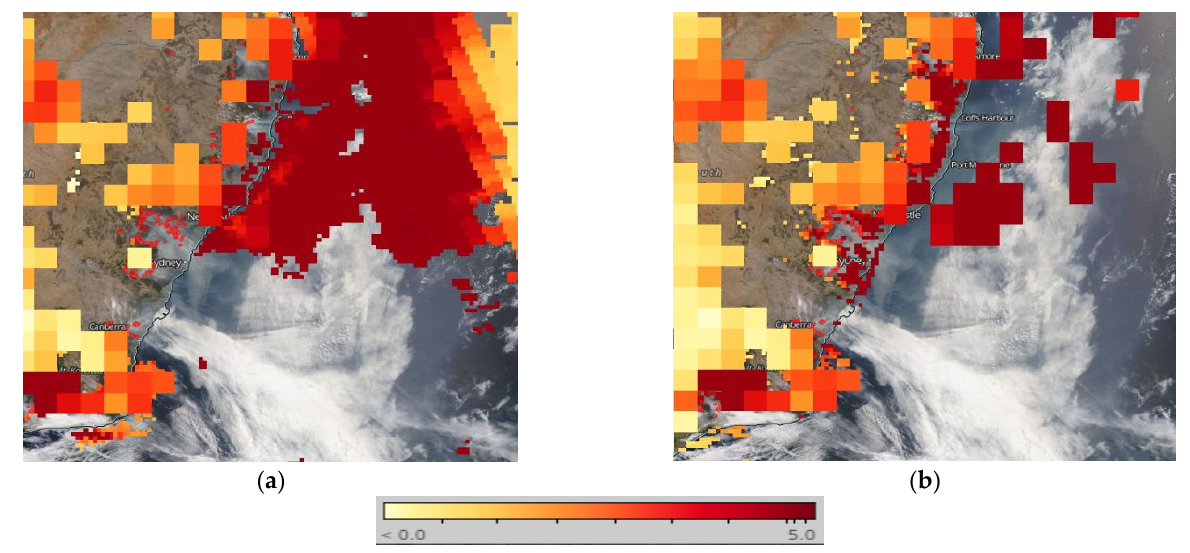
Figure 9. Elevated aerosol values (red) are indicated by the aerosol optical depth (AOD) from the ( a ) Aqua and ( b ) Terra sensors on the MODIS satellite. Sites of high bushfire activity (red dots) on 10 December 2019 are also indicated. ( https://worldview.earthdata.nasa.gov (accessed on 20 January